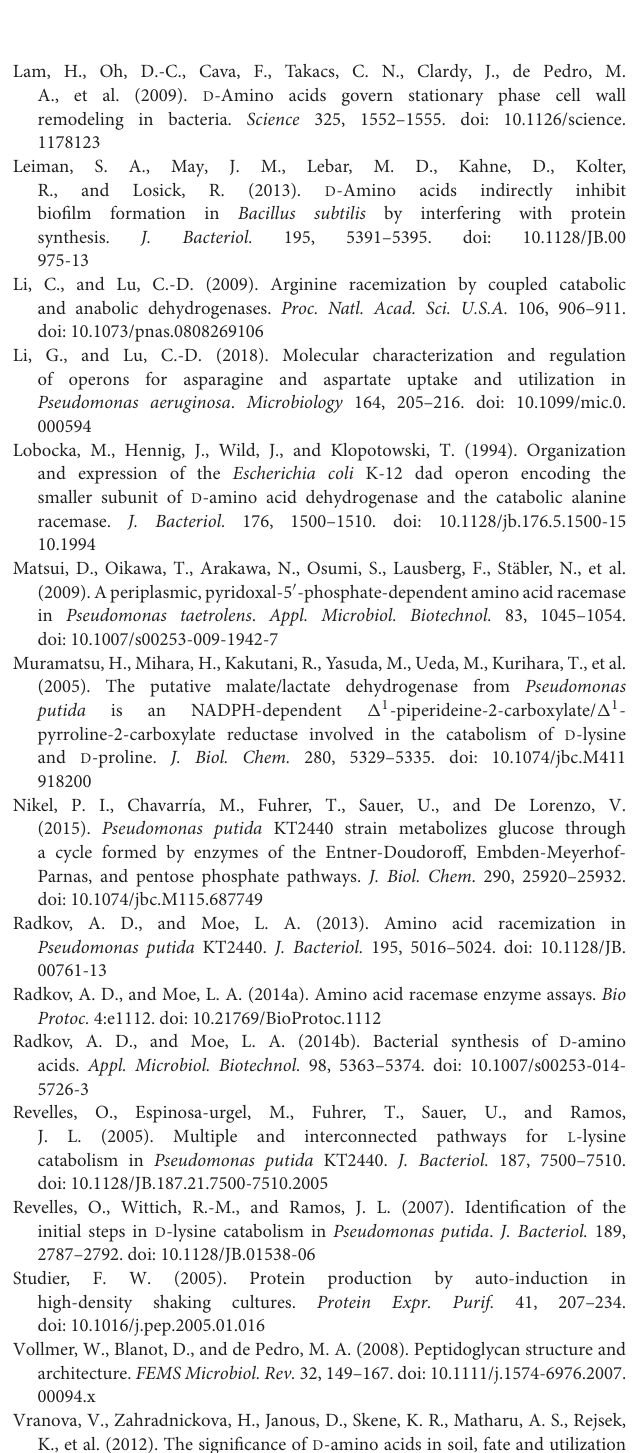
Figure S1 | OD600 values for growth of wt and 1 alr strains on 19 L-AAs. Figure S2 | OD600 values for growth of wt and 1 alr strains on 19 D-AAs. Table S1 | Protein fraction identification using known enzyme activity